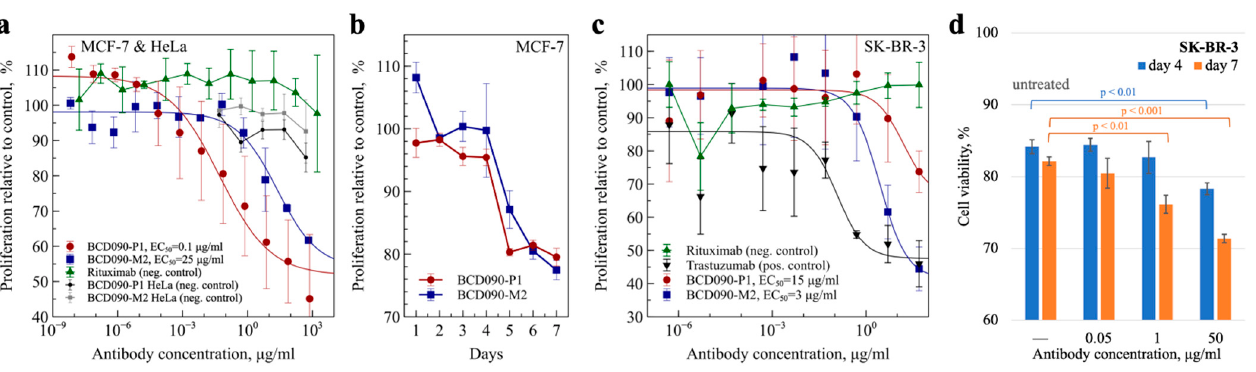
Figure 6. Inhibition of ErbB3-driven proliferation of cancer cells. ( a ) The antiproliferative action of BCD090-P1 or BCD090- M2 on MCF-7 cells, rituximab and HeLa cells expressing negligible amounts of ErbB3 were used as negative controls; ( b ) the growth curves of MCF-7 cells treated with 50 μ g/mL single-domain antibodies; ( c ) antiproliferative action of BCD090- P1, BCD090-M2 or trastuzumab on SK-BR-3 cells; ( d ) the viability of SK-BR-3 cells treated with a mixture of the two single- domain antibodies. The dose–response curves were fitted by the Hill equation. All data represent the mean of three repli- cates ± SD, p -values were calculated using t -test.